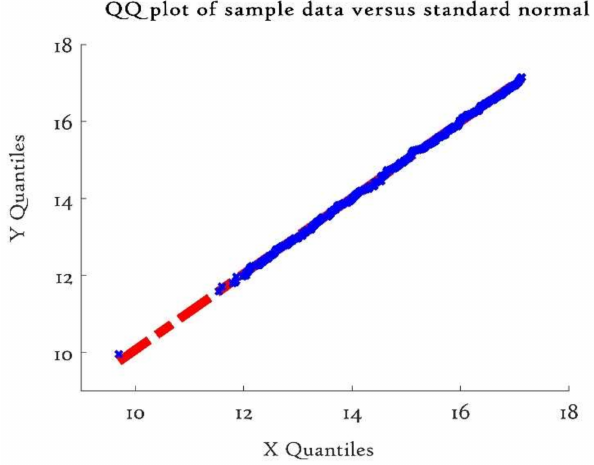
Figure 19. QQ plot for GP rotor speed curve.